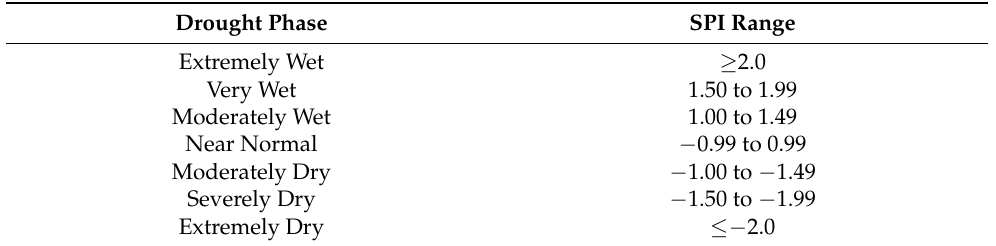
Table 2. SPI classification according to the drought phase [55].